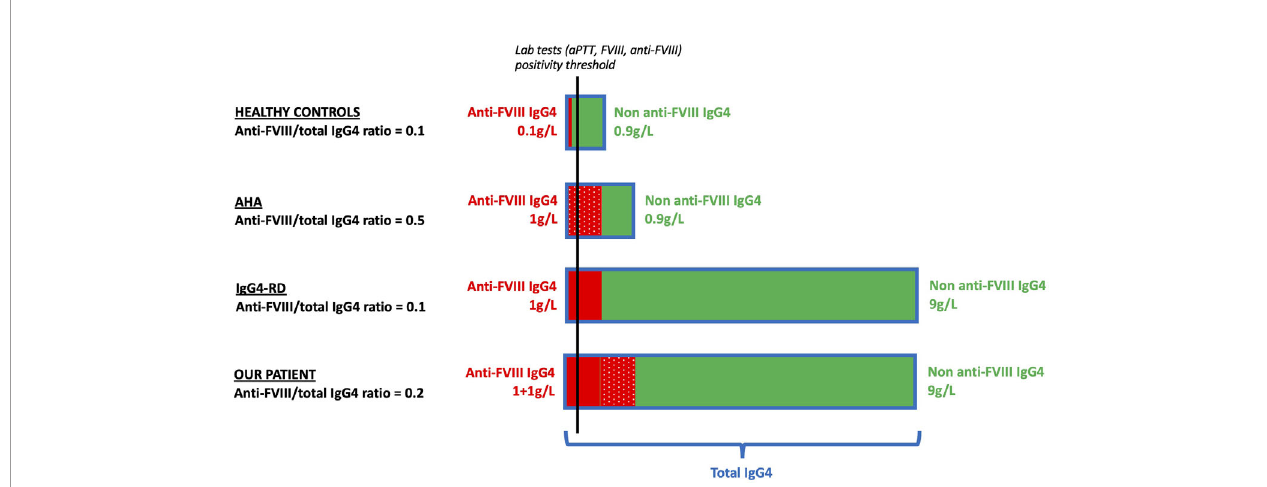
FIGURE 4 | Schematic representation of the putative mechanisms responsible for anti-FVIII antibody production in healthy controls ( fi rst row), AHA patients (second row), IgG4-RD patients (third row), and in our patient (fourth row). We hypothesized the ratios of anti-FVIII IgG4/total IgG4 in four populations: First row: healthy controls. A small fraction of the IgG4 repertoire has anti-FVIII activity (plain red) compared to non-anti-FVIII IgG4 (green). The anti-FVIII IgG4/total IgG4 ratio is 0.1. Second row: AHA. The anti-FVIII IgG4 fraction (dotted red) is produced by an antigen-driven oligoclonal expansion of a small contingent of pathogenic plasma cells. The rest of the IgG4 repertoire (green) remains similar to healthy controls. The anti-FVIII IgG4/total IgG4 ratio is 0.5. Third row: IgG4-RD. The anti-FVIII IgG4 fraction (plain red) is the result of an overall expansion of the IgG4 repertoire. As the anti-FVIII (plain red) and non-anti-FVIII (green) IgG4 fractions are both increased in similar proportion to healthy controls, the anti-FVIII IgG4/total IgG4 ratio is 0.1 (identical to healthy controls and lower than AHA). Fourth row: our patient. The anti-FVIII is a combination of both previous mechanisms: bystander production by polyclonal proliferation of IgG4 + plasma cells (plain red) and antigen-driven production due to broken tolerance to FVIII leading to (dotted red). The non-anti-FVIII (green) is increased in similar proportion to IgG4-RD patients. The anti-FVIII IgG4/total IgG4 ratio is 0.2 (higher than IgG4-RD and lower than AHA). In order to simplify the explanation, qualitative values are displayed. AHA, acquired hemophilia A; anti-FVIII, anti-FVIII activity; aPTT, activated partial thromboplastin time; FVIII, coagulation factor VIII; HC, healthy controls; Ig, immunoglobulin; IgG4-RD, IgG4-related